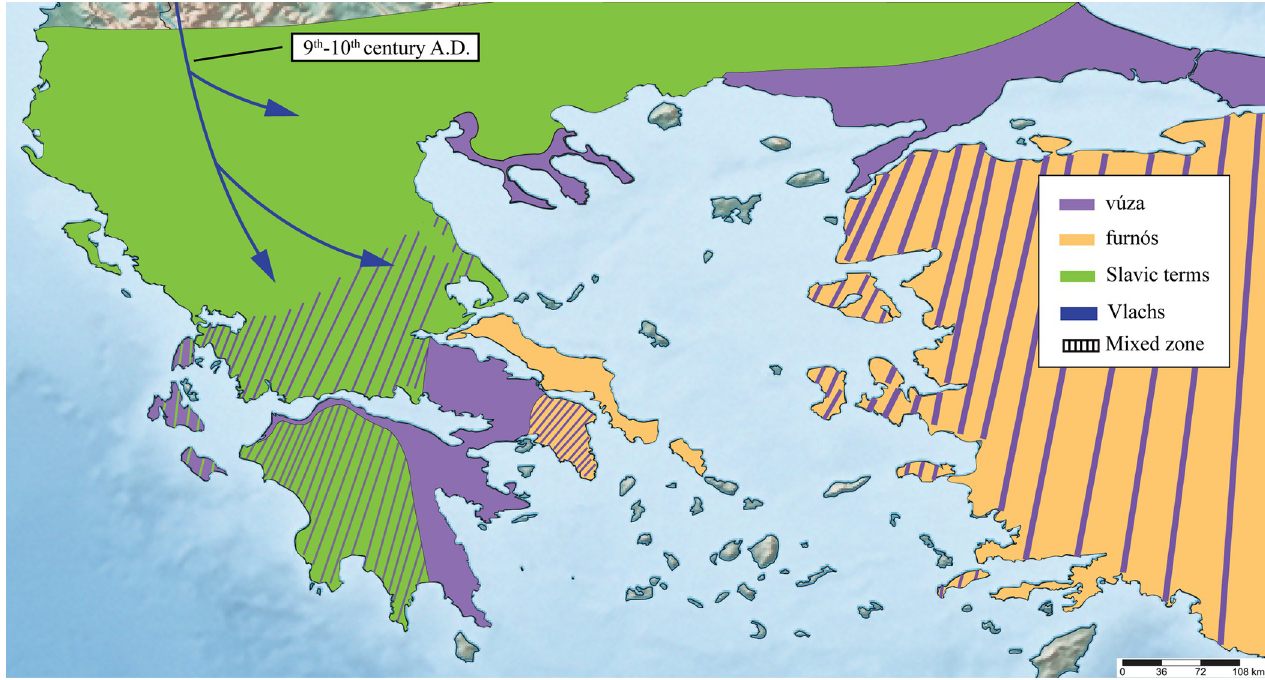
Fig 7. Hypothetical distribution of toad zoonyms in Greece shortly after the Slavic settlements (7 th –9 th century AD), during the first Vlach movements in the area (blue arrows). The spread of each zoonym was designed according to data from its current distribution, as well as contemporary historical sources. In particular, the distribution of Slavic terms was plotted based on evidence of strong Slavic presence, such as Slavic place names and sclaveniae (i.e. areas of dense Slavic settlement) [14]. The hypothetical presence of the term β ού z α ( vúza ) in the Peloponnese, Boeotia, and Macedonia was also based on its current range and the areas known to have remained under Roman Imperial control throughout the Migration Period [48, 49, 78]. It should be noted that this map does not exclude the likely presence of large Greek-speaking populations within areas where Slavic terms predominated, who continued using Greek zoonyms, until they were gradually replaced by Vlach